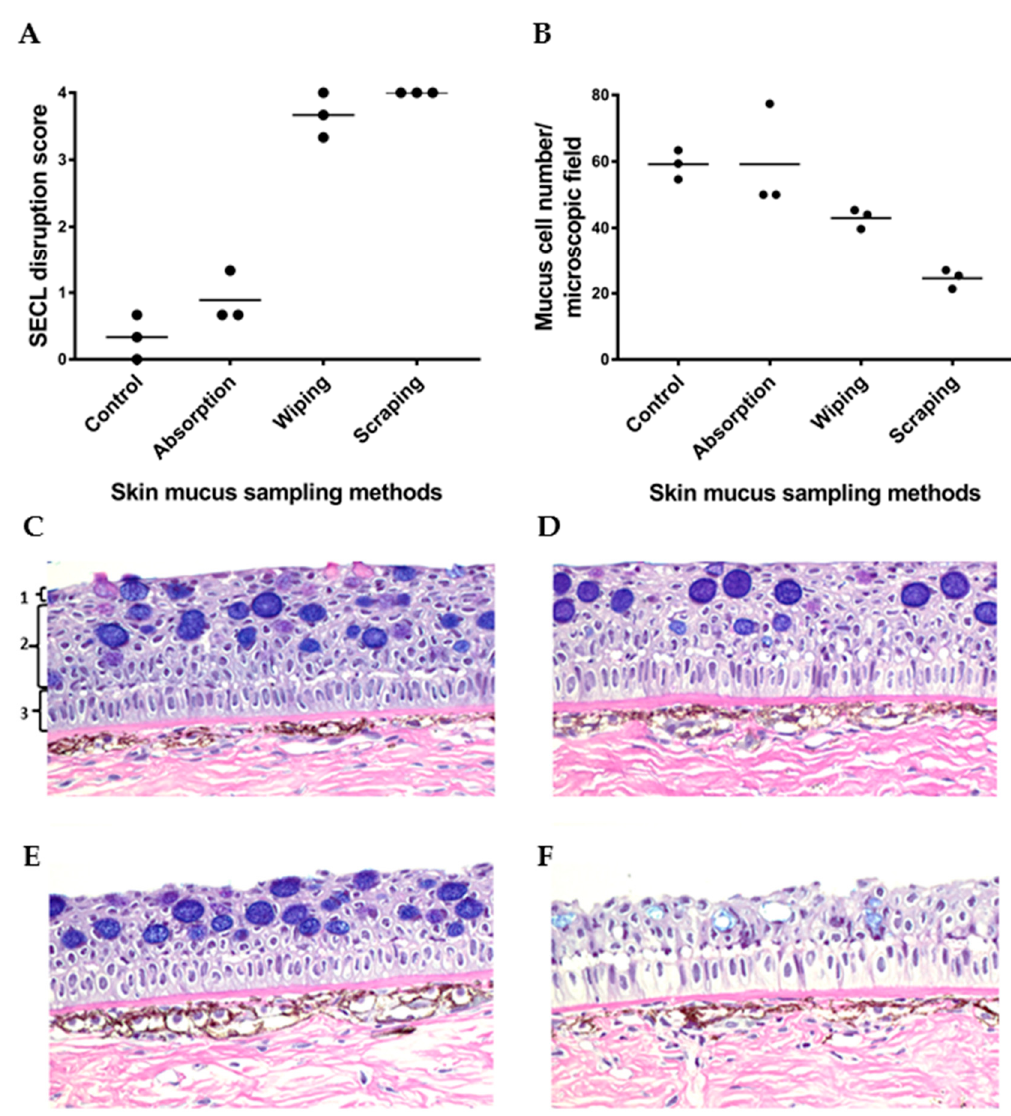
Figure 5. Evaluation of the invasiveness of three skin mucus sampling methods (absorption, wiping and scraping) to salmon skin after mucus sampling. ( A , B ) Comparison of SECL disruption score ( A ) and mucous cell number in skin epidermis / microscopic field ( B ) between skin mucus sampling methods after mucus sampling. Horizontal lines represent the median in the di ff erent groups of samples. ( C – F ) Histology sections of salmon skin samples from occipital head region stained with Alcian blue / periodic acid-Schi ff showing the e ff ect of di ff erent skin mucus sampling methods on the integrity of the skin epidermis. ( C ) Control fish skin showing the normal structure of salmon skin, as well as the following epidermal layers: (1) squamous epithelial cell lining, (2) cuboidal epithelial cell layers, and (3) basal columnar epithelial cell layer. The remaining histological images show that the sampling methods di ff er in the extent to which they disrupt the epidermis, with the absorption method ( D ) being the least disruptive to the three epithelial cell layers indicated in panel A, followed by the wiping method ( E ), and finally the scraping method ( F ) being the harshest to them. The microscopic images in ( C – E ) and F were taken of skin section with 0, 1, 3 and 4 SECL disruption score, respectively. All images were captured at 40× magnification.